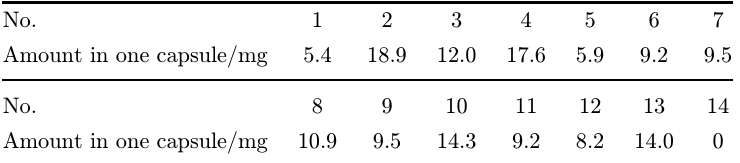
Table 4. Positive samples with diclofenac sodium and negative samples without diclofenac